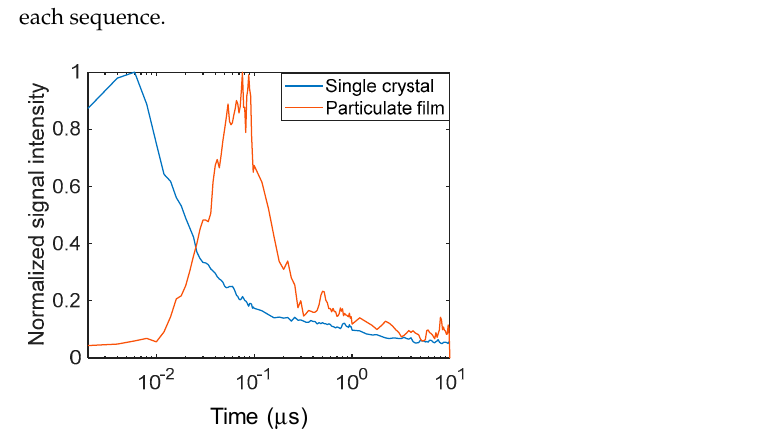
Figure 5. The normalized temporal responses of the refractive index changes for the particulate film and the single crystal of SrTiO 3 are shown. The signal amplitude was calculated from the images of Figure 4.